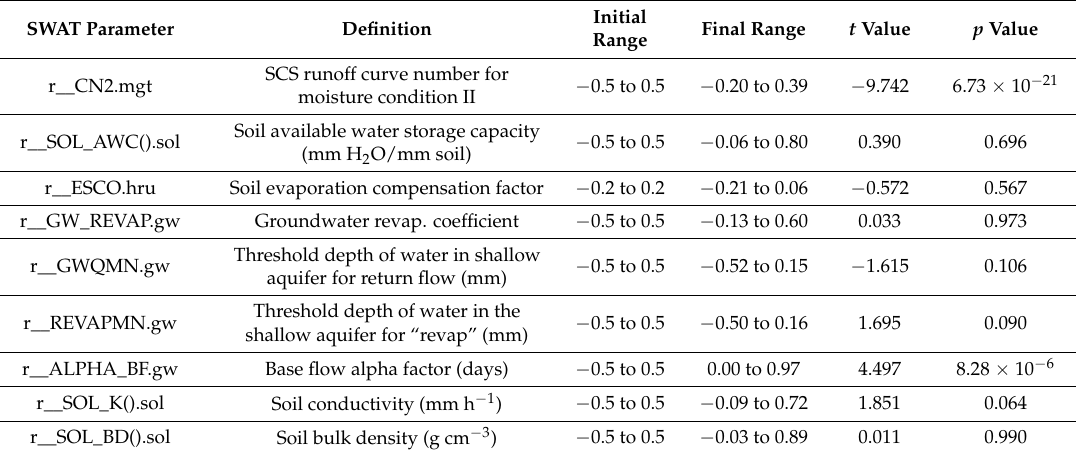
Table 3. List of the model calibration